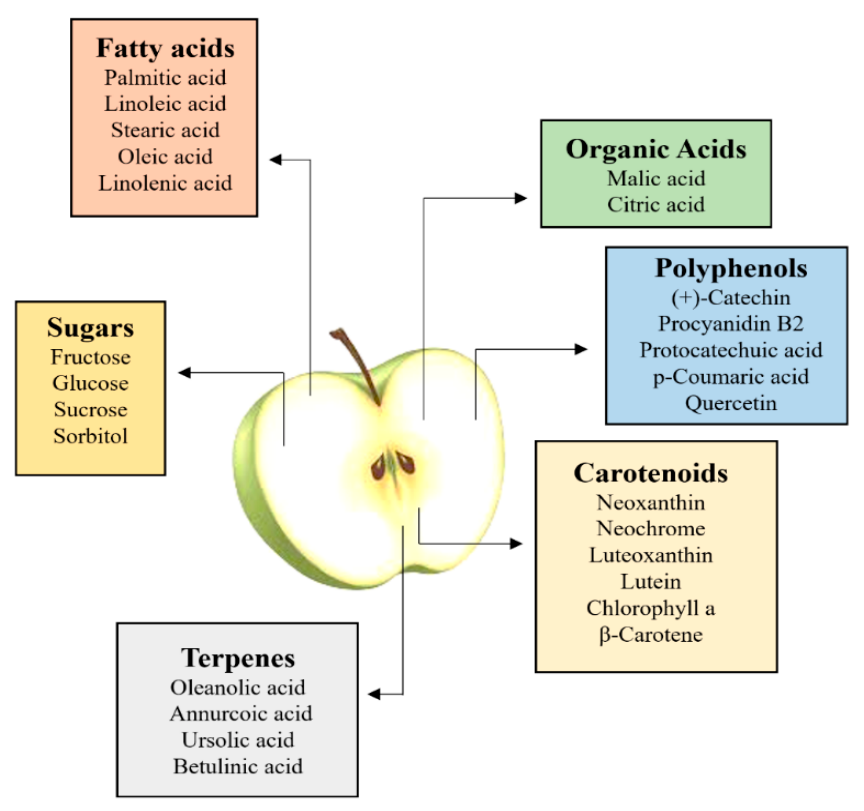
Figure 1. Main primary and secondary metabolites related to functional and nutraceutical values of apples.